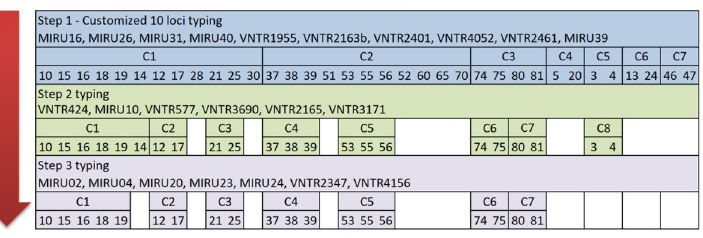
Fig 3. Stepwise application of customized and additional 14 loci and distribution of the clustered samples. Selected loci for the stepwise approach and distribution of the clustered samples after typing with customized 10-loci set, step two typing with 6 loci and step 3 typing with remaining 8 loci.